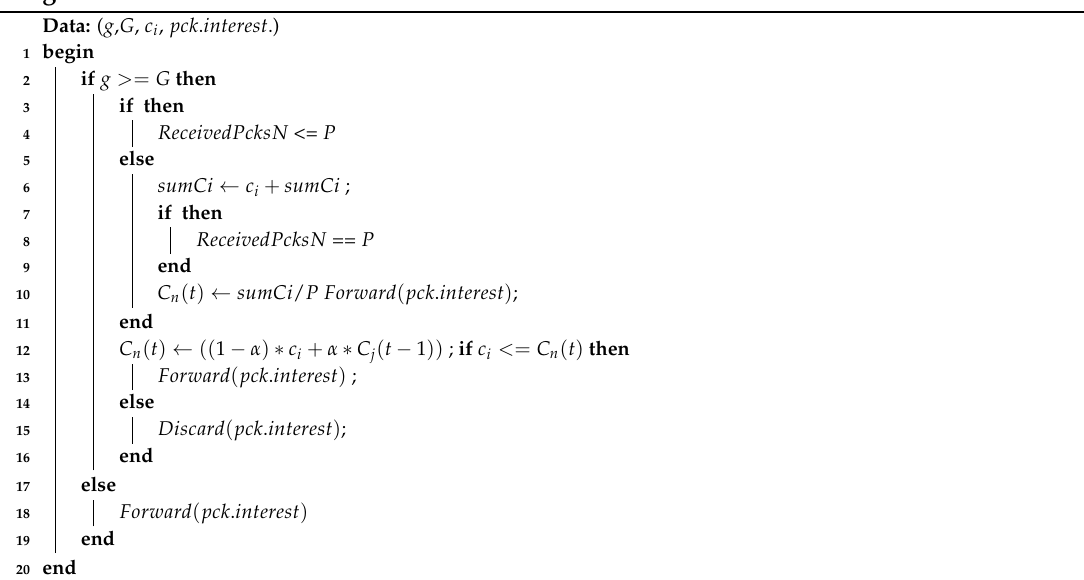
Algorithm 3: ReCIF-soft